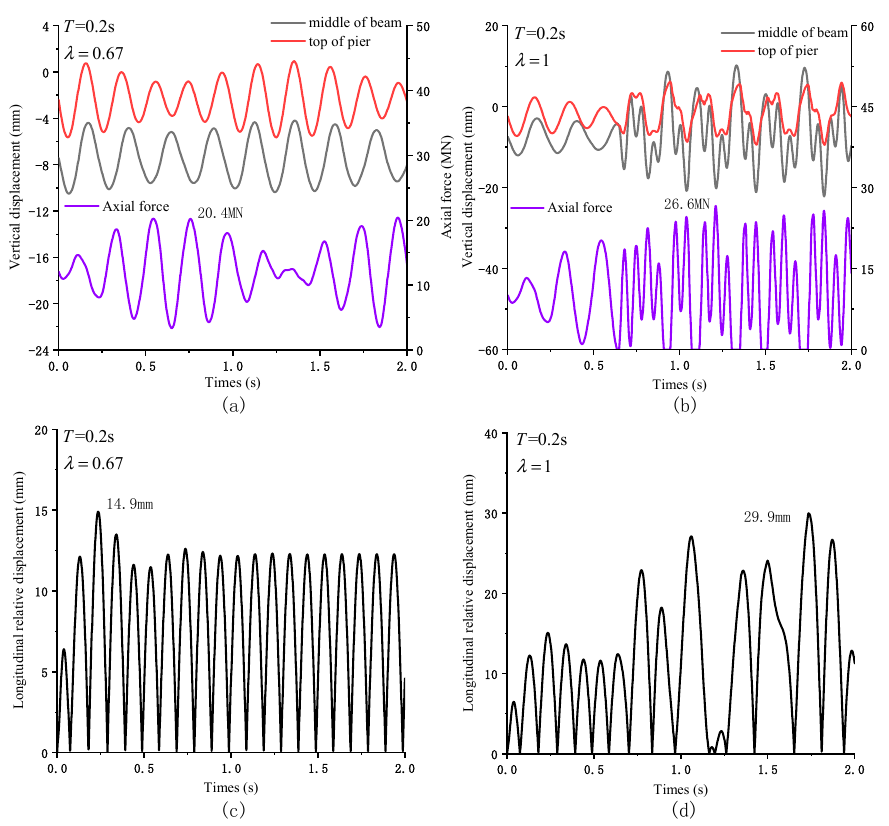
Figure 4. Seismic response of the bridge under different λ : ( a ) The vertical displacement and contact force response of the bridge when λ = 0.67; ( b ) The vertical displacement and contact force response of the bridge when λ = 1; ( c ) Longitudinal relative displacement of pier beam when λ = 0.67; ( d ) Longitudinal relative displacement of pier beam when λ = 1.